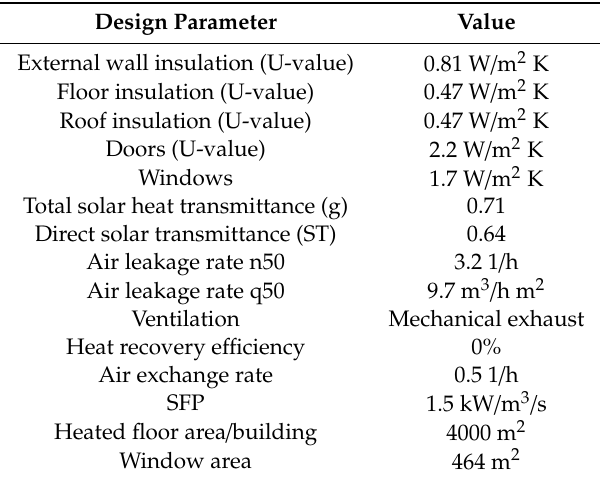
Table 1. The design parameters of the original-reference (OR) building constructed in the 1970s